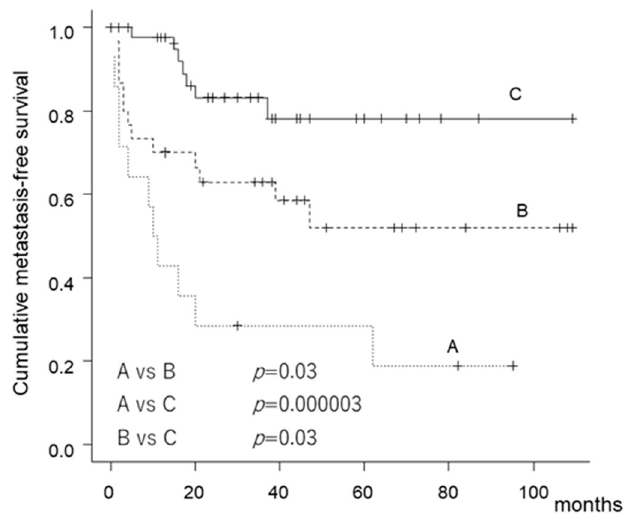
Figure 2. Kaplan–Meier curve showing metastasis-free survival according to the expression of IL-6 and IL-6R in the tumor tissue.